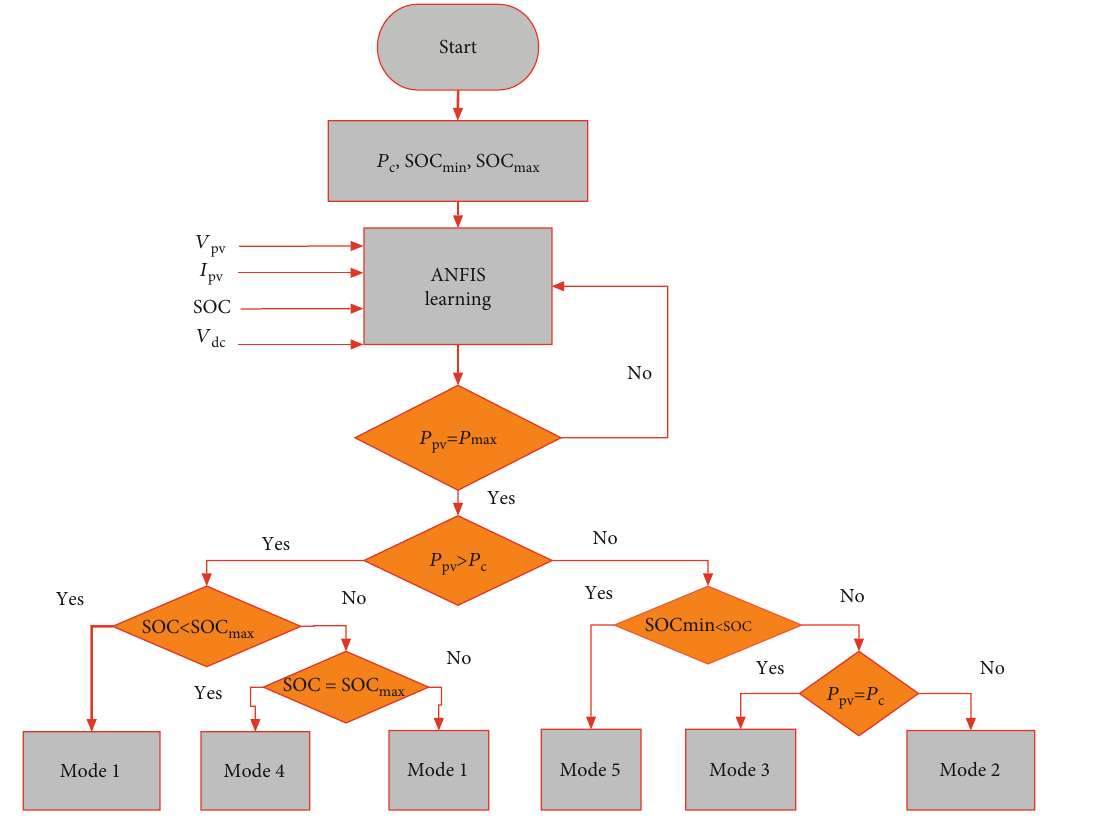
Figure 6: MPPT and supervision